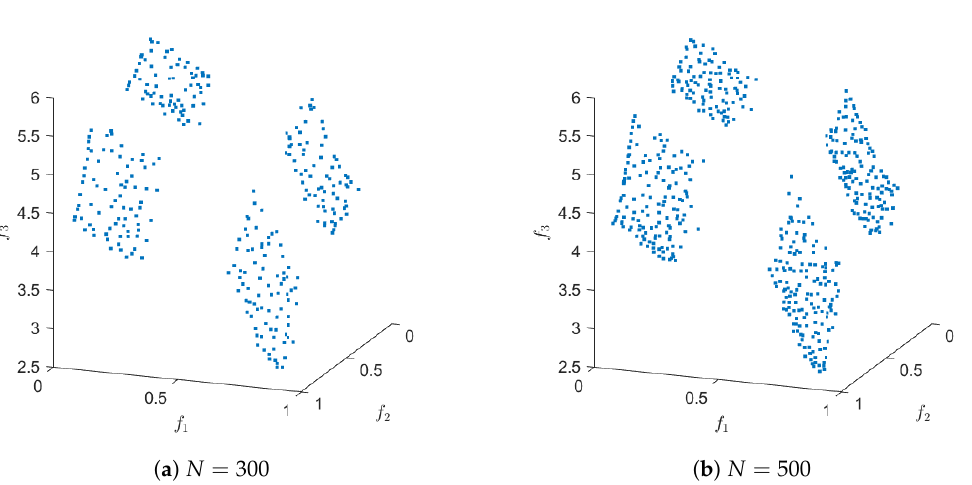
Figure 9. Results of ArchiveUpdateHD on DTLZ7 for different values of N .